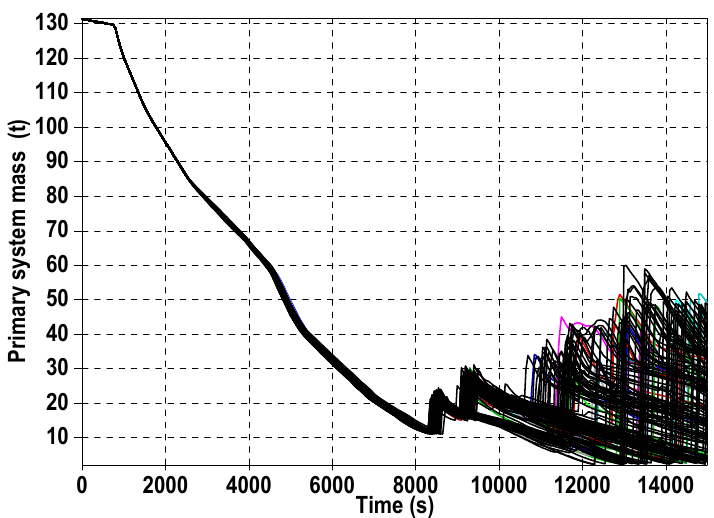
Figure 4. Primary system mass.